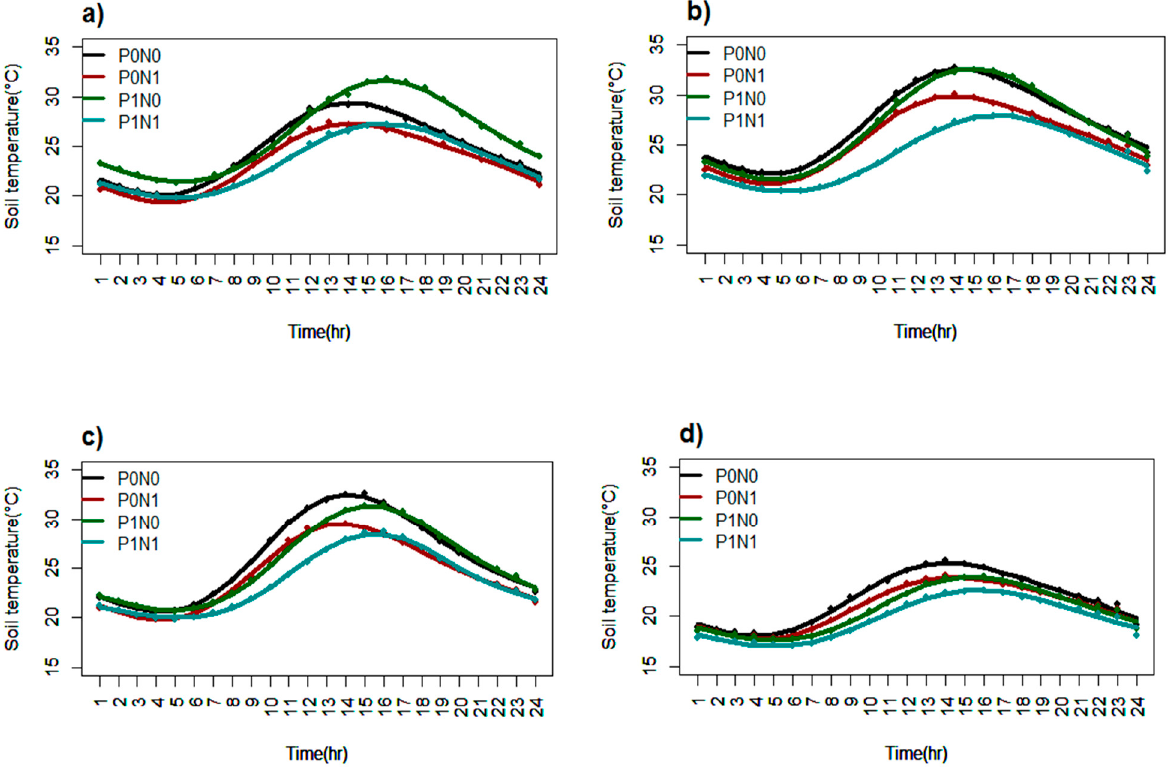
management over the studied years: ( a ) 2014 ( b ) 2015 ( c ) 2016 ( d ) Figure 3. Variation of the soil temperature at 5 cm soil depth for the hottest day under various man- agement over the studied years: ( a ) 2014 ( b ) 2015 ( c ) 2016 ( d ) 2017.